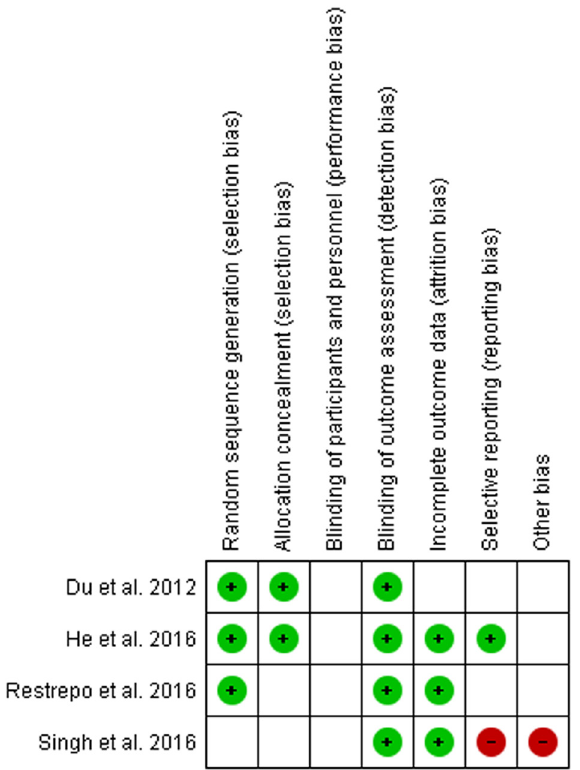
Figure 2. Risk of bias for included